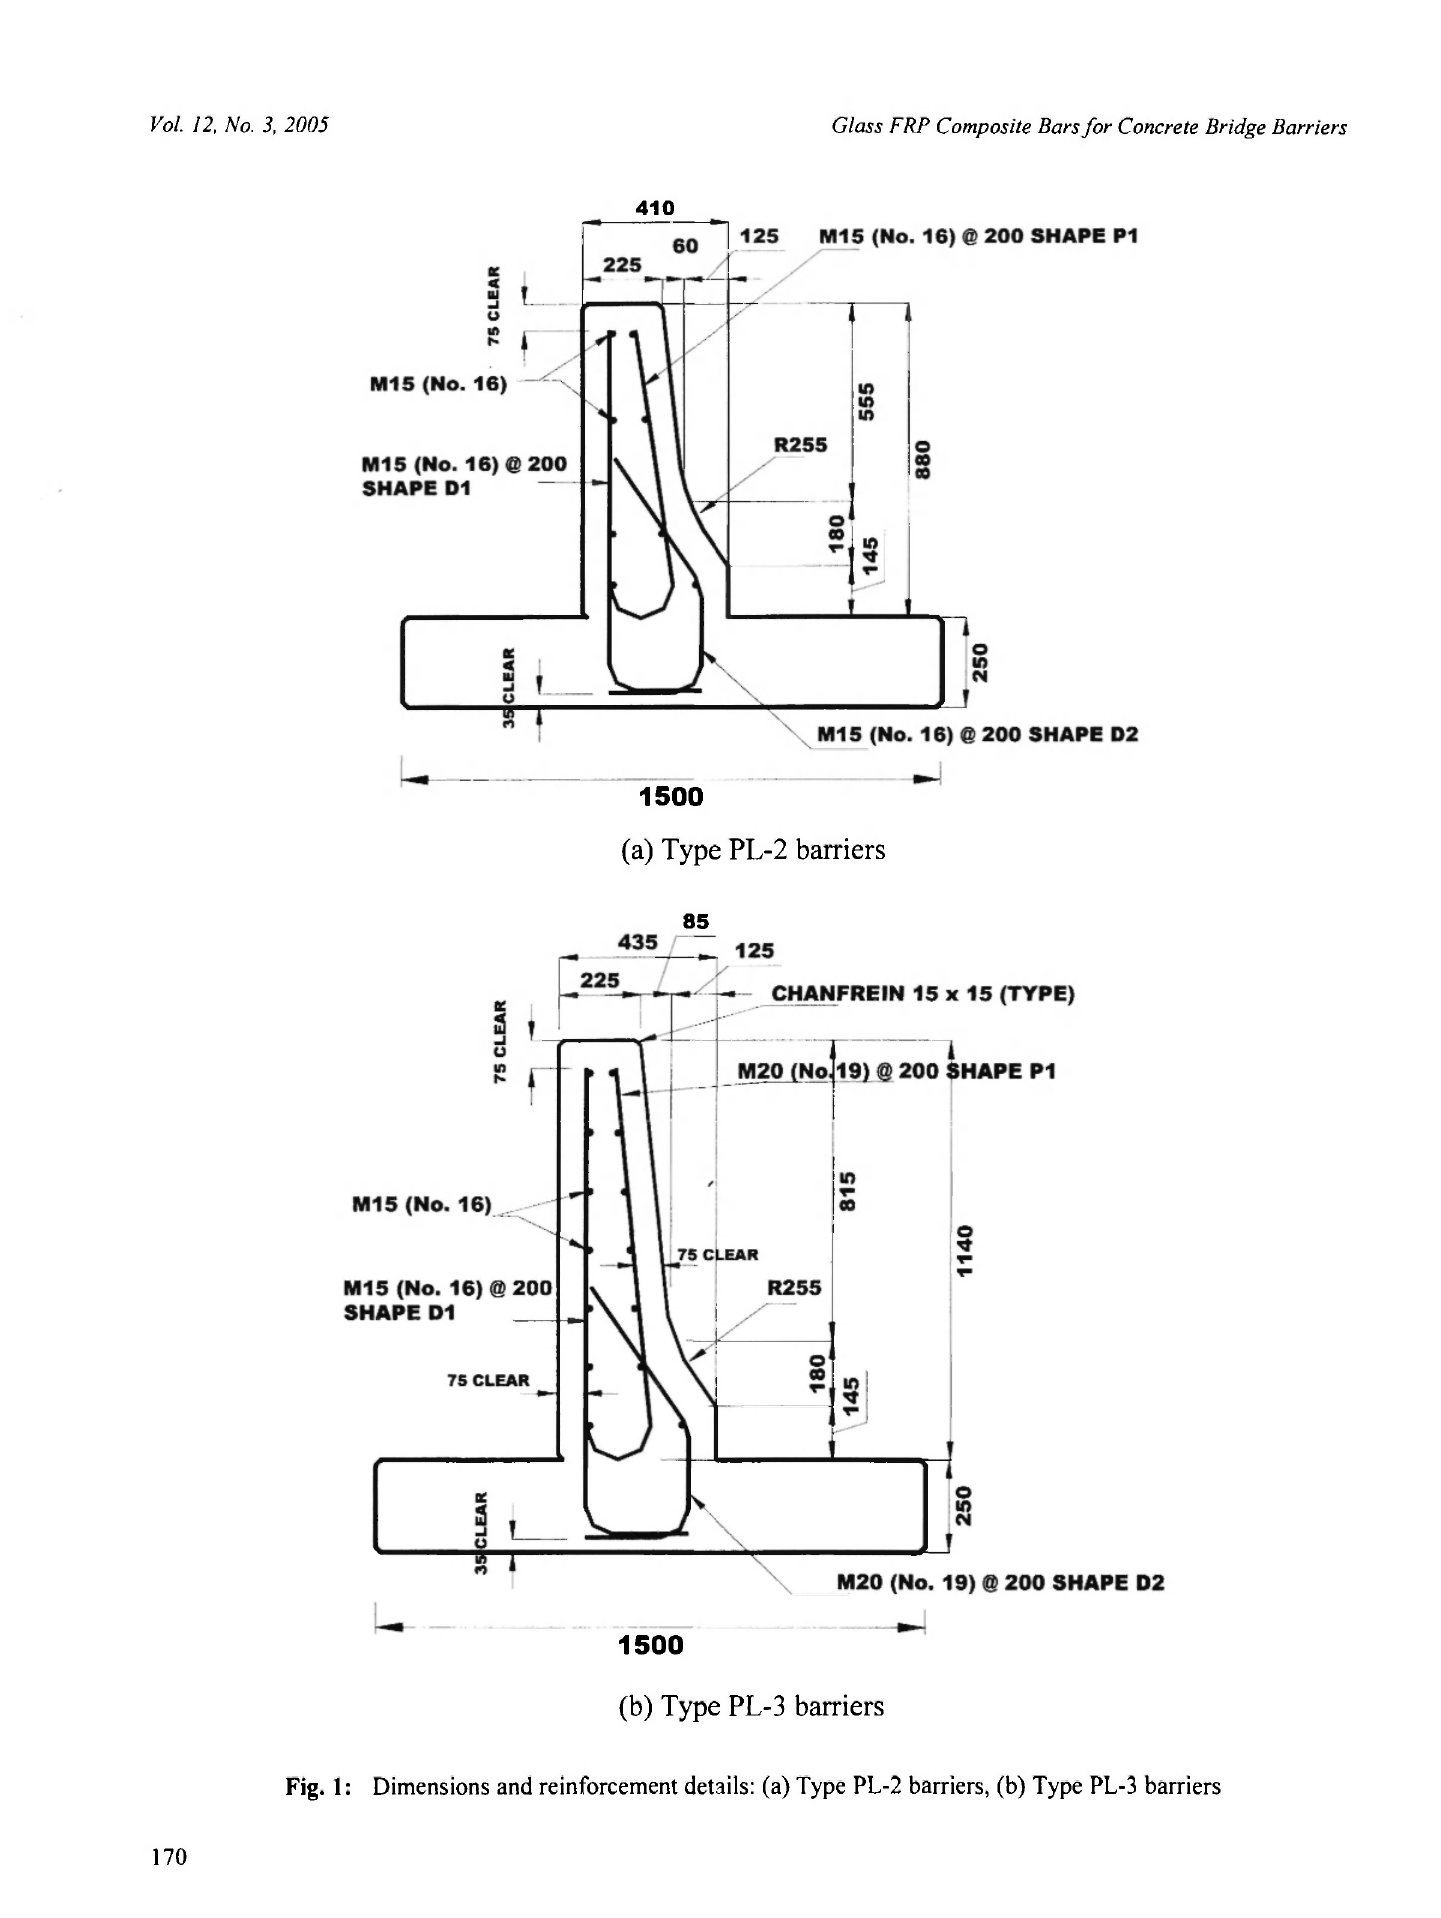
Fig. 1: Dimensions and reinforcement details: (a) Type PL-2 barriers, (b) Type PL-3